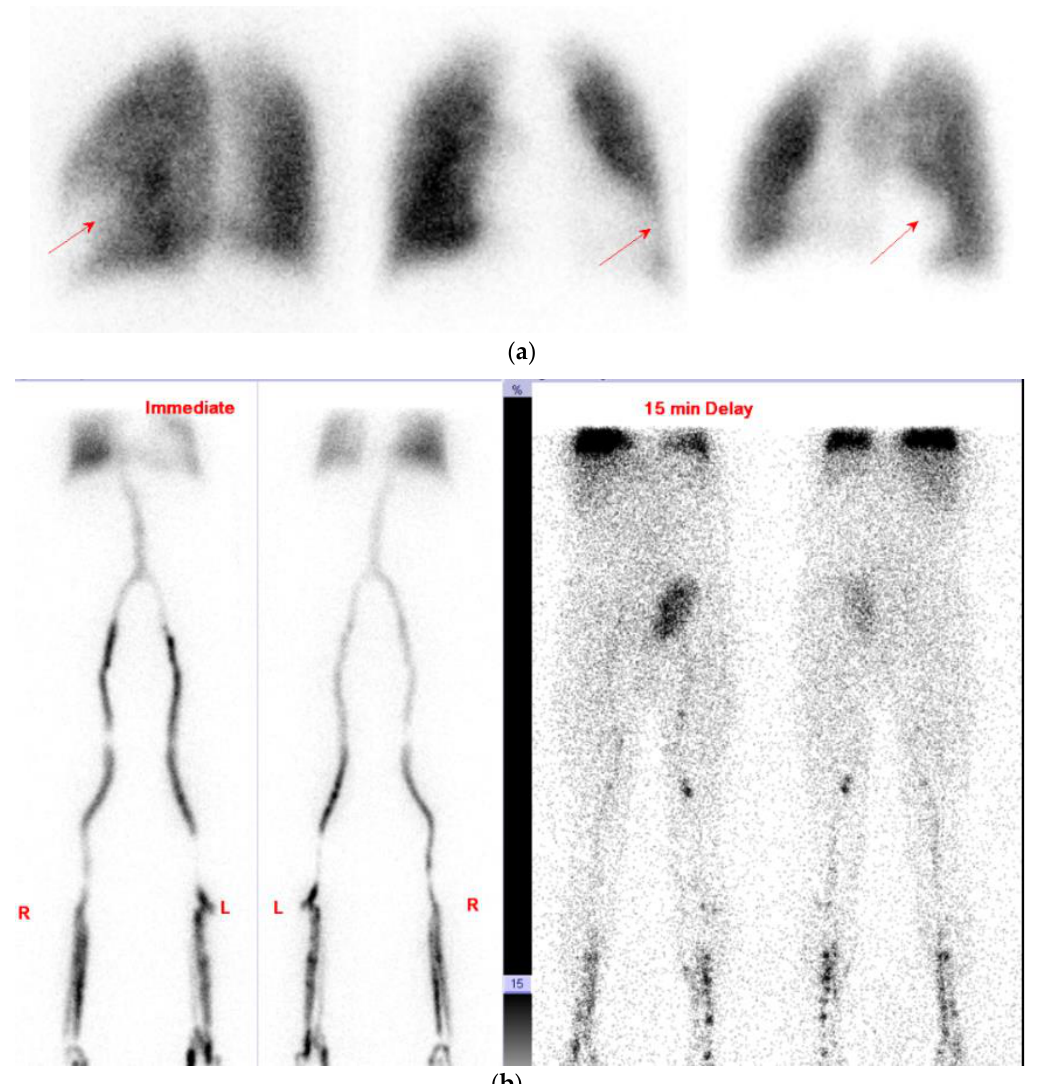
Figure 2. ( a ) Pulmonary perfusion scan showed a segmental cold area in the lingual inferior segment of left upper lobe, the arrow shows the defect; ( b ) Venography study showed well visualization of the deep veins in the bilateral lower extremities with good drainage of radioactivity up to the inferior vena cava.